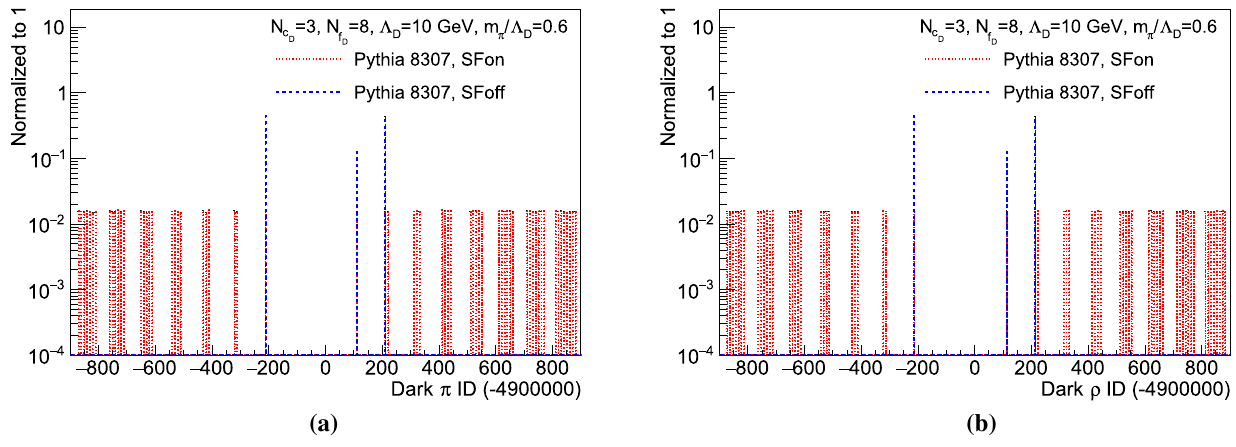
= 3, N = 8 model: a PdgId distribution for dark pions, b PdgId distribution for ρ Fig. 32 N c f D D